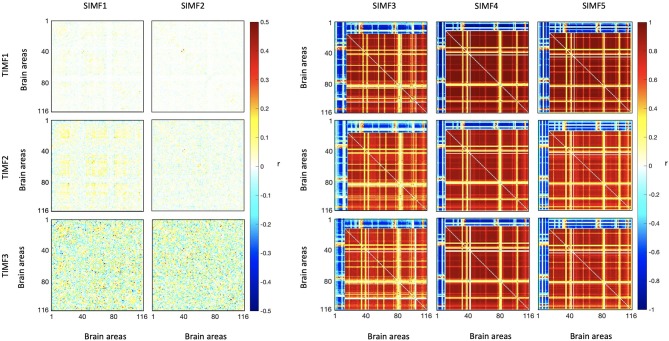
Functional connectivity matrices of the whole brain regions using AAL 116 atlas for different spatial and temporal IMFs. Pearson's correlation coefficient (r) with P ≤ 0.01 is computed between all the brain regions' spatiotemporal domains extracted from fMRI data. Spatial domains are extracted by applying FATEMD method on fMRI signal. The three temporal domains including TIMF1, TIMF2, and TIMF3 are computed by applying ICEEMDAN on each SIMF. SIMF, Spatial Intrinsic Mode Function; TIMF, Temporal Intrinsic Mode Function; ICEEMDAN, Improved Complete Ensemble Empirical Mode Decomposition with Adaptive Noise; FATEMD, Fast and Adaptive Empirical Mode Decomposition.